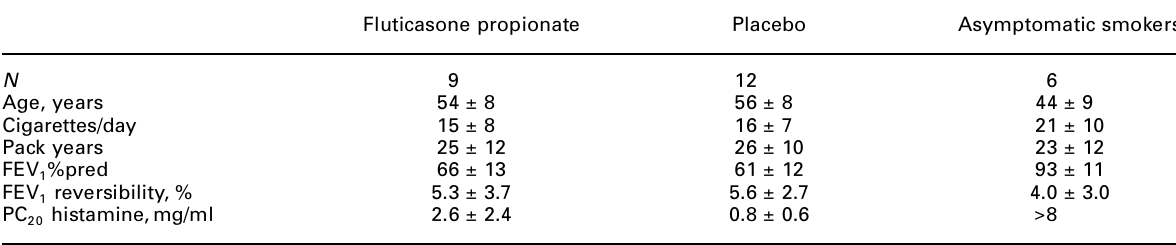
Table 1. Patient characteristics